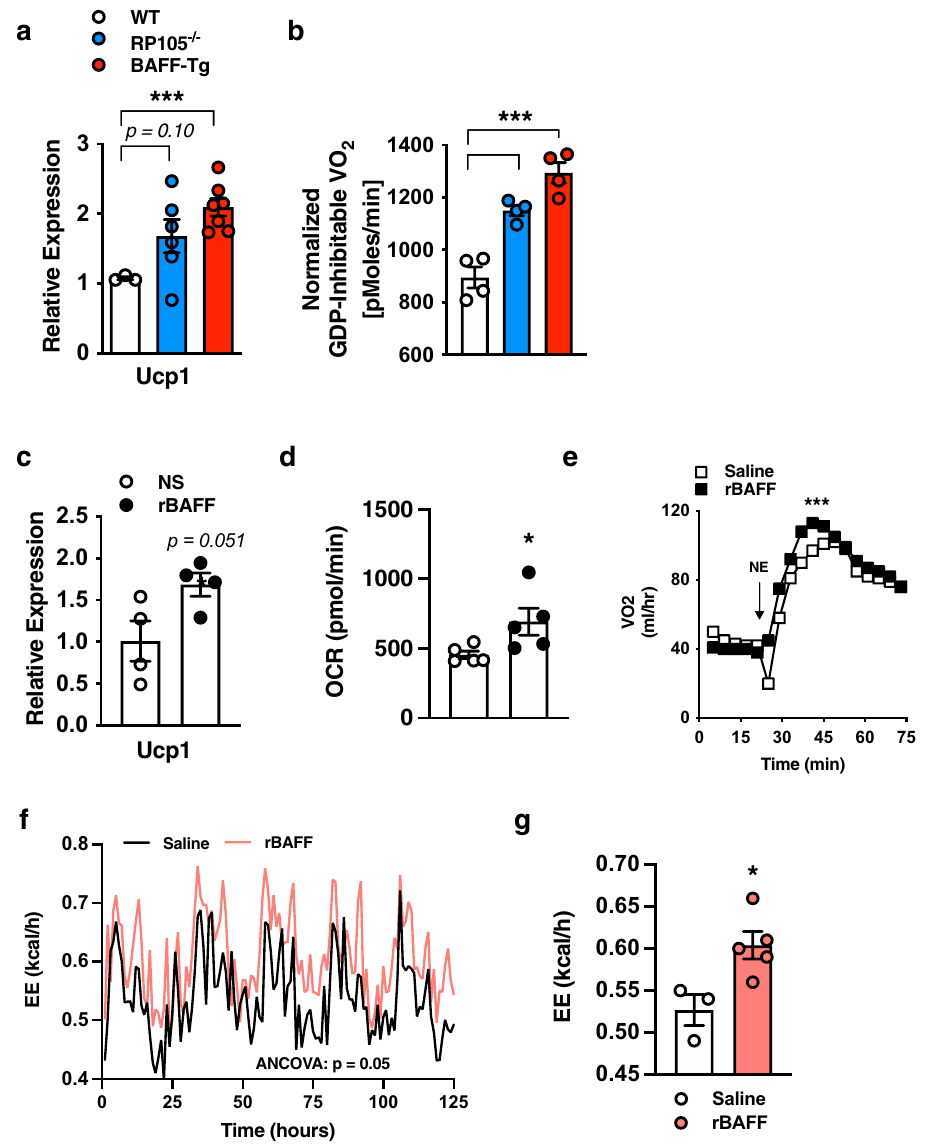
Fig. 3 BAFF modi fi es brown adipose adaptive thermogenesis. a – b WT, RP105 − / − , or BAFF-Tg mice were fed HFD for 20 weeks. a BAT Ucp1